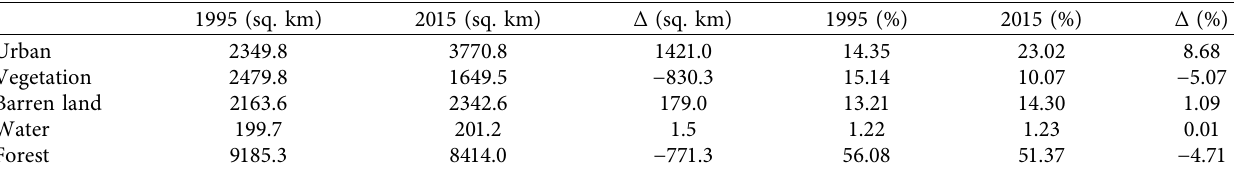
Table 6: A real change of LULC categories in different time spans between 1995 and 2015.